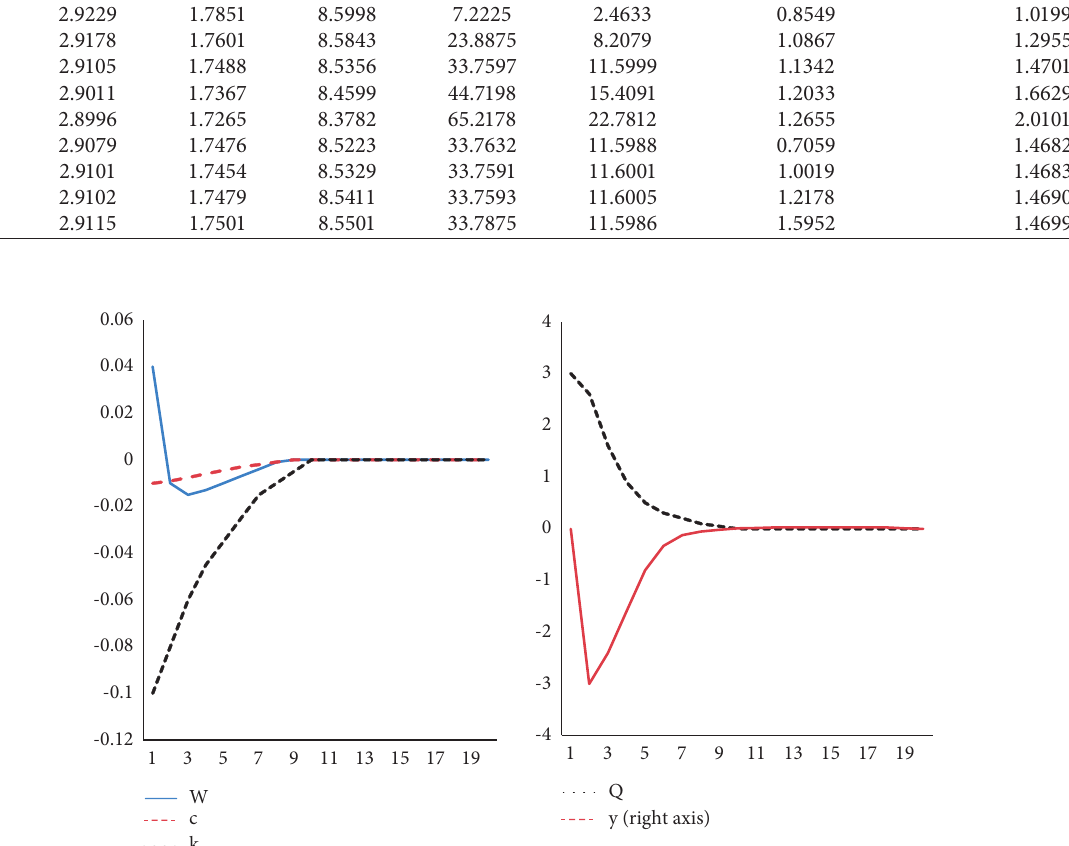
Figure 4: Response diagram of some endogenous variables under the impact of government environmental preference.